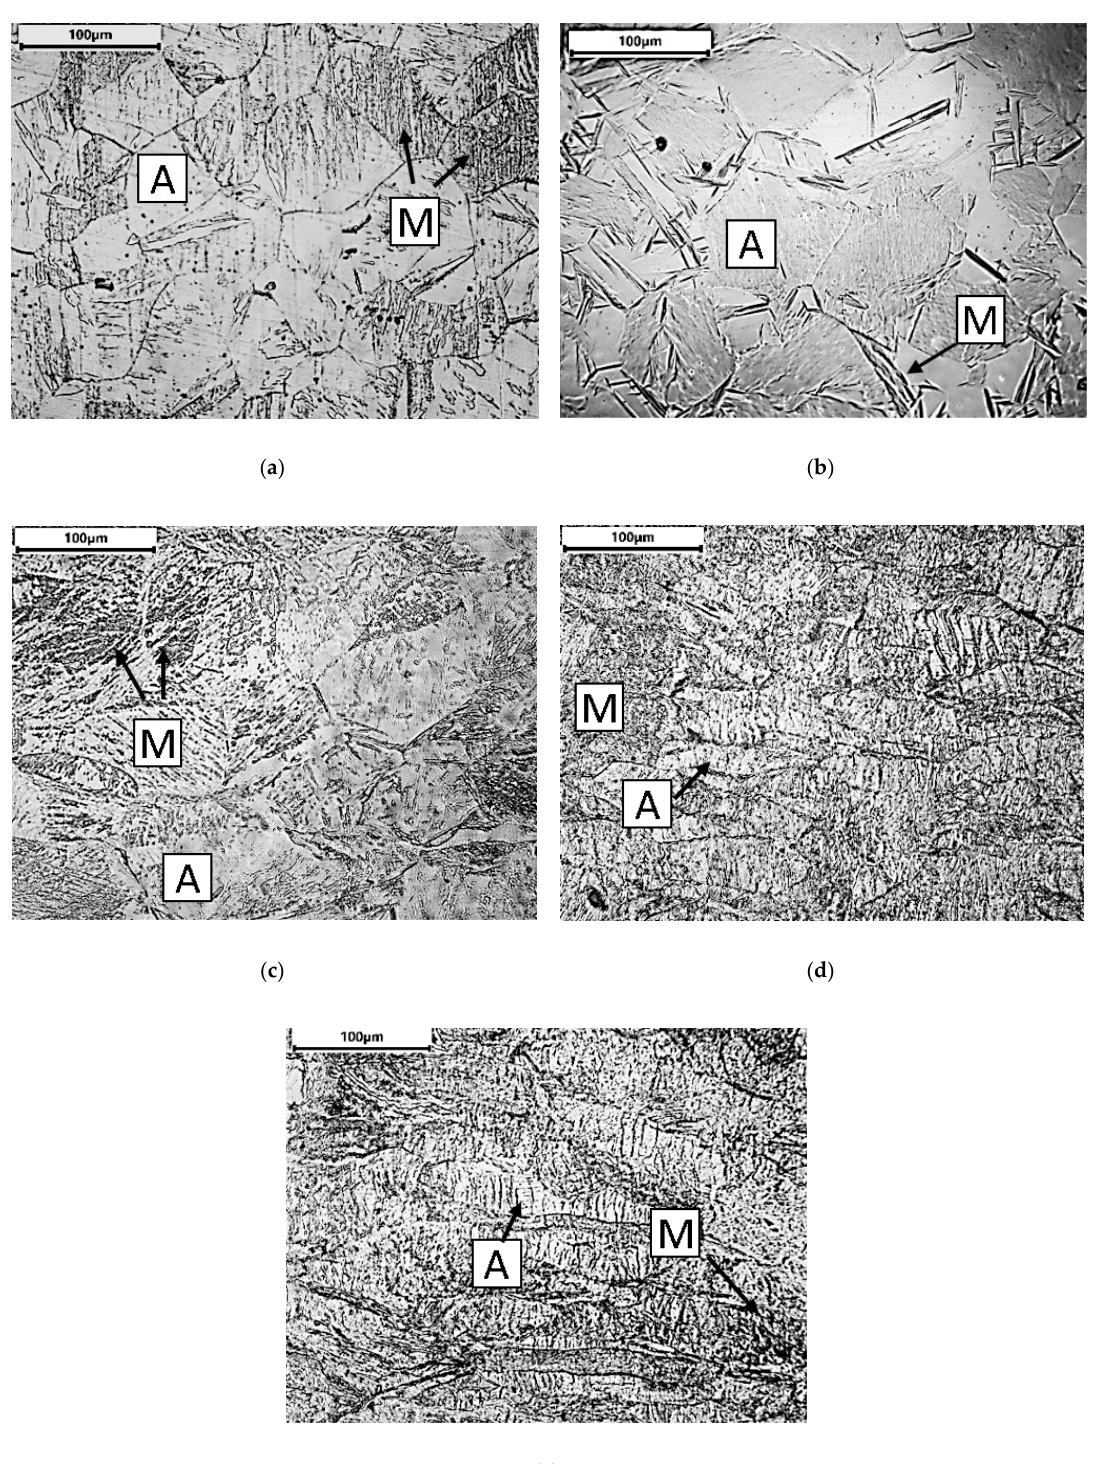
Figure 2. Structure of TRIP steel in di ff erent states: after annealing at T = 875 K, τ = 1 h ( a ); after austenitization ( b ); 40% reduction ( c ); 51% reduction ( d ); 63% reduction ( e ).